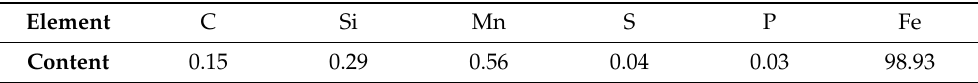
Table 6. Chemical compositions of the steel reinforcement in this study